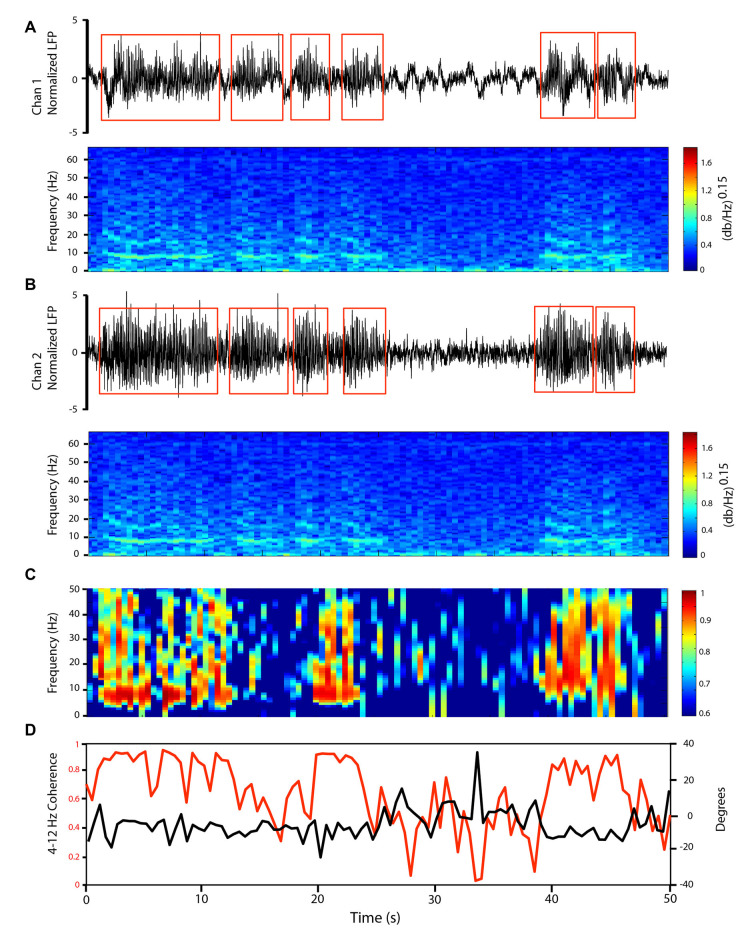
LFP oscillations at 4–12 Hz in the cerebellar cortex GCL show variable coherence patterns across time. Simultaneous GCL LFP recordings from two microelectrodes distanced ~3 mm (Chan 1 in paramedian lobule, Chan 2 in Crus II). (A,B) Simultaneously recorded GCL LFPs (top) and corresponding frequency spectrogram (bottom) showing changes in oscillatory activity through time. LFP trace amplitude z-score normalized, to perform oscillatory episode detection. Detected episodes of oscillation are represented by the red square box. Frequency spectrogram shown with 1-s windows. (C) Coherence spectrogram, 1-s windows, showing 0–50 Hz coherence patterns in time. (D) 4–12 Hz Coherence (red line), and corresponding phase lag (black line) between the two LFP traces.